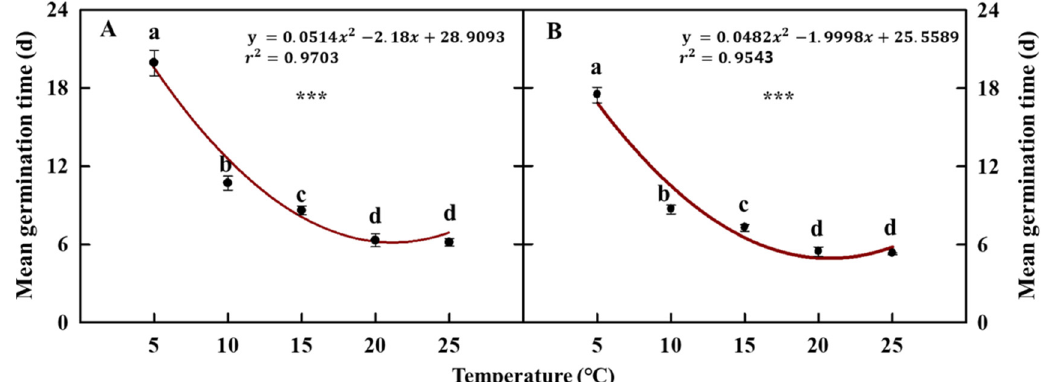
Figure 6. Mean germination time (MGT) of cold stratification treated coastal glehnia seeds with pericarps ( A ) and without pericarps ( B ) at five different air temperatures (5, 10, 15, 20, and 25 °C) for 31 days. The vertical bars indicate standard errors. Different letters showed significant differences. *** indicates significance at p < 0.001 ( n = 4).